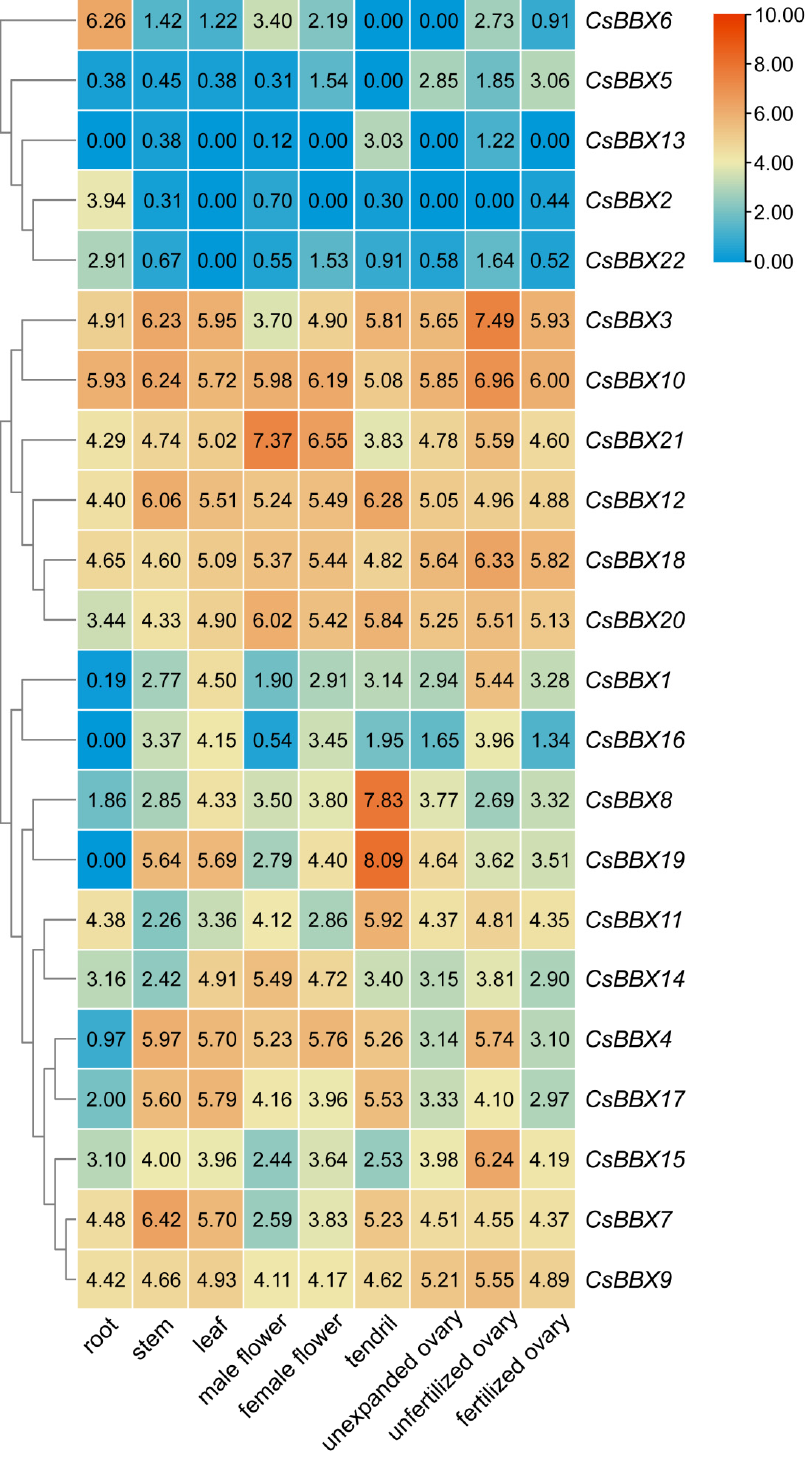
Figure 5. Expression levels of CsBBX genes in various cucumber tissues. The expression data were displayed and clustered with TBtools using log 2 -transformed TPM values (log 2 (TPM + 1)).